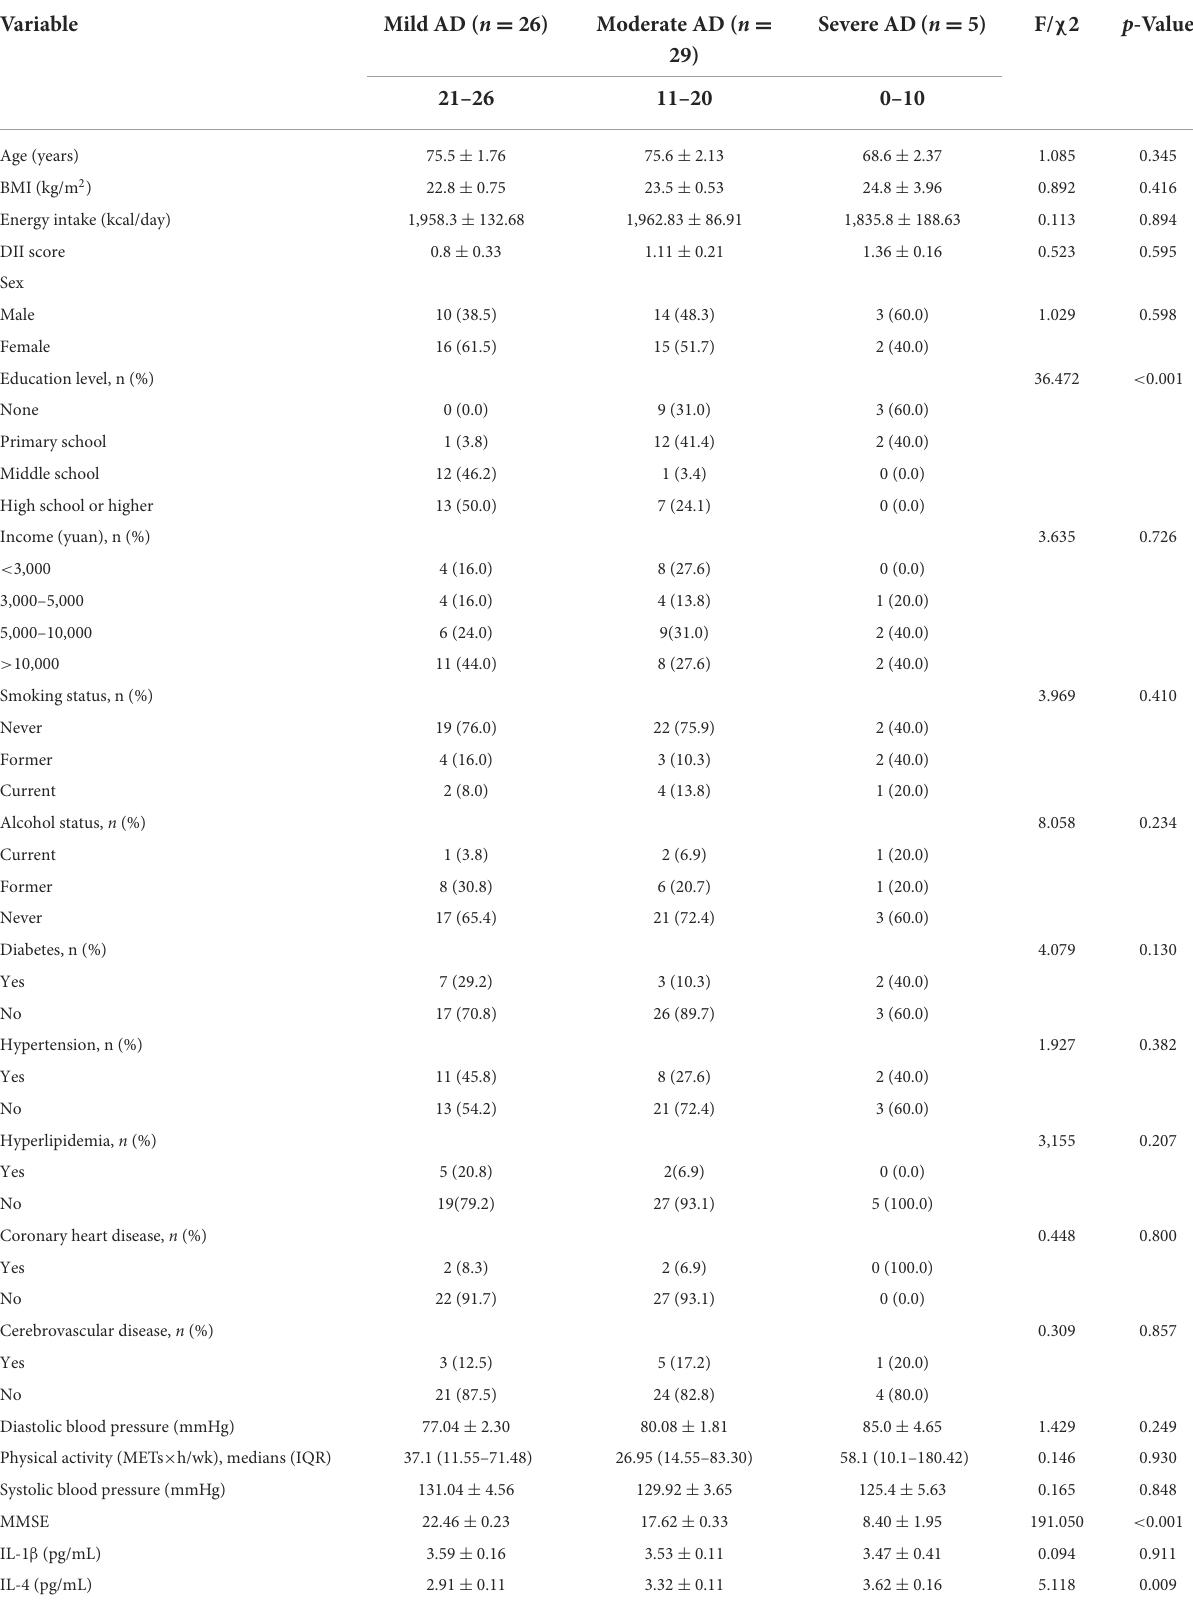
TABLE 4 Baseline characteristics and inflammatory factors in different severity of